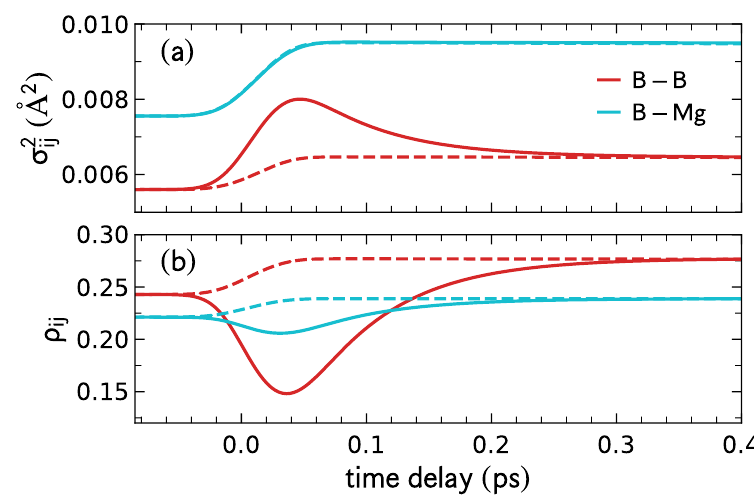
Figure 4: (a) Time evolution of the mean-square relative lattice displacement σ 2 as defined by Eq. (15), for the in-plane nearest neighbor B-B bond, and for the nearest neighbor B-Mg bond. Solid lines show the hot-phonon scenario, whereas dashed lines represent the time behavior assuming a a thermal phonon distribution as modelled by Eqs. (10)-(11). (b) Corresponding correlation functions ρ